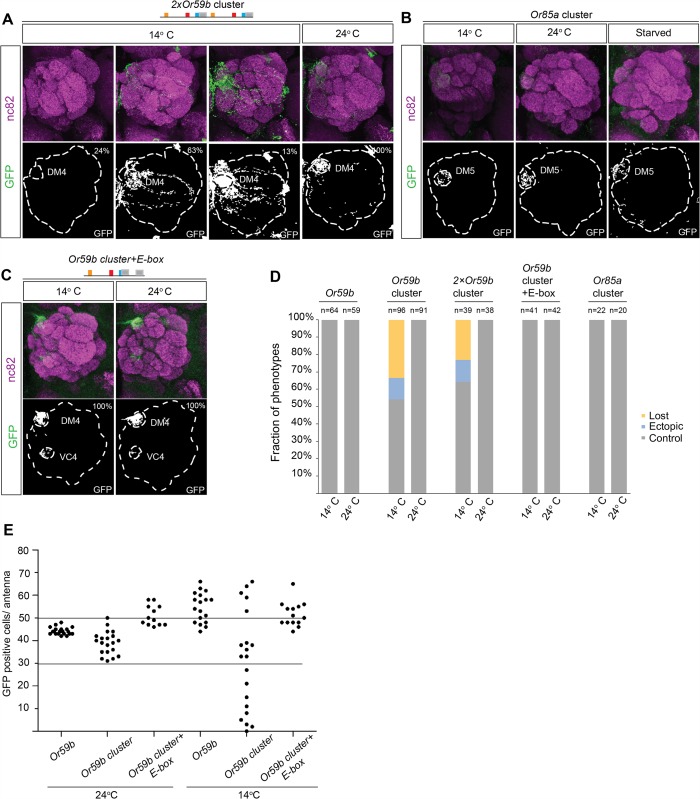
Cooperative regulation between the cluster and surrounding motifs produces robust class-specific expression.(A) GFP expression (green) driven by the 2×Or59b cluster at 14°C and 24°C. Note the three expression phenotypes produced by the 2×Or59b cluster at 14°C. Synaptic neuropil regions are labeled with the presynaptic marker nc82 (magenta). (B) GFP expression (green) produced by the Or85a cluster at 14°C, 24°C or following 3 days of starvation. Note that GFP expression is equally strong in different lines at 14°C. (C) The Or59b cluster with an additional E-box produces robust expression at 14°C and 24°C. (D) The fractions of the brains showing stable or bimodal expression of GFP according to the genotype and temperature. Note that only the Or59b cluster and 2×Or59b cluster are unstable at 14°C. (E) Quantification of GFP positive cells in the antenna. Or59b cluster shows a varied number of GFP positive cells at 14°C compared to 24°C. Or59b and Or59b cluster with an additional E-box show stable expression in both temperatures. Schematic interpretations of the results are presented in S6 Fig.